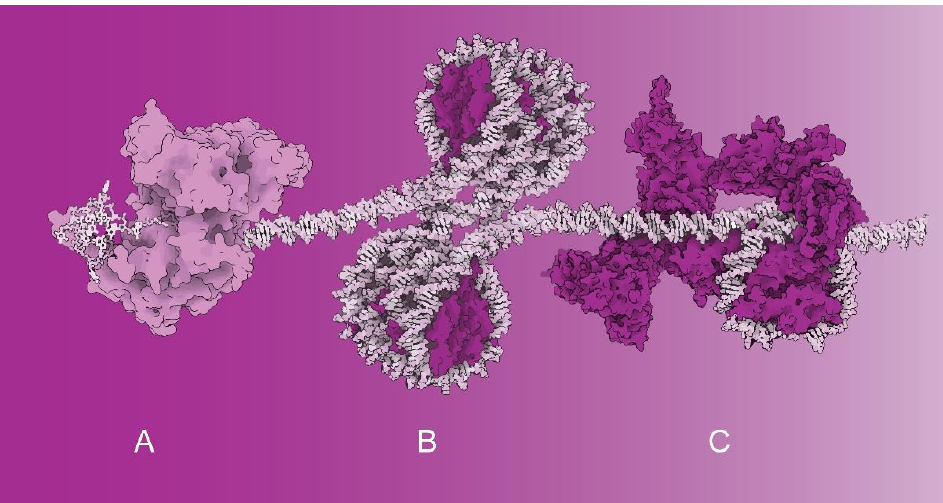
Figure 1. The molecular complexes regulating transcription activation that have been